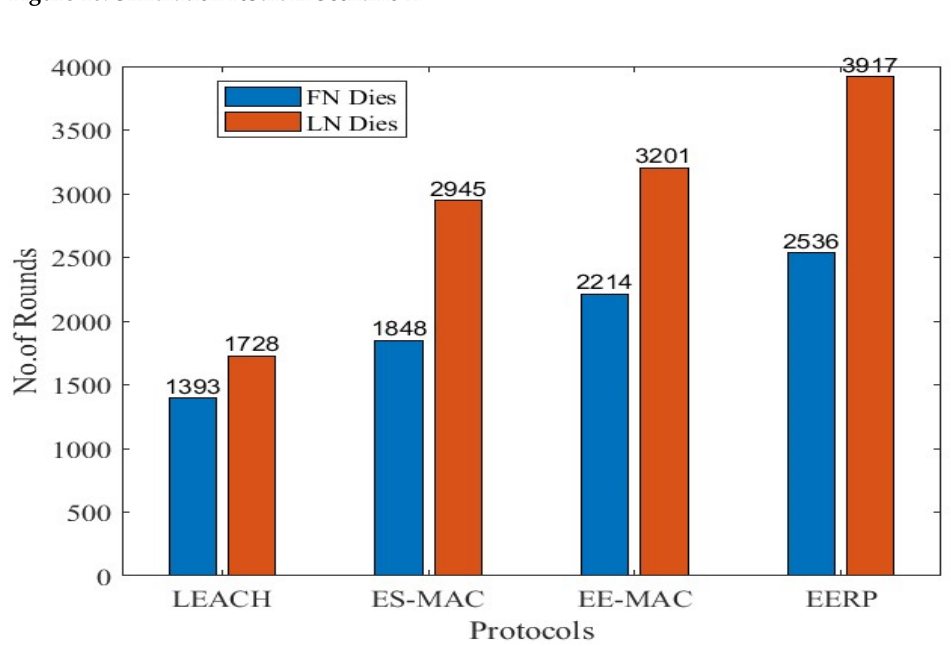
Figure 10. Simulation result in Scenario 2